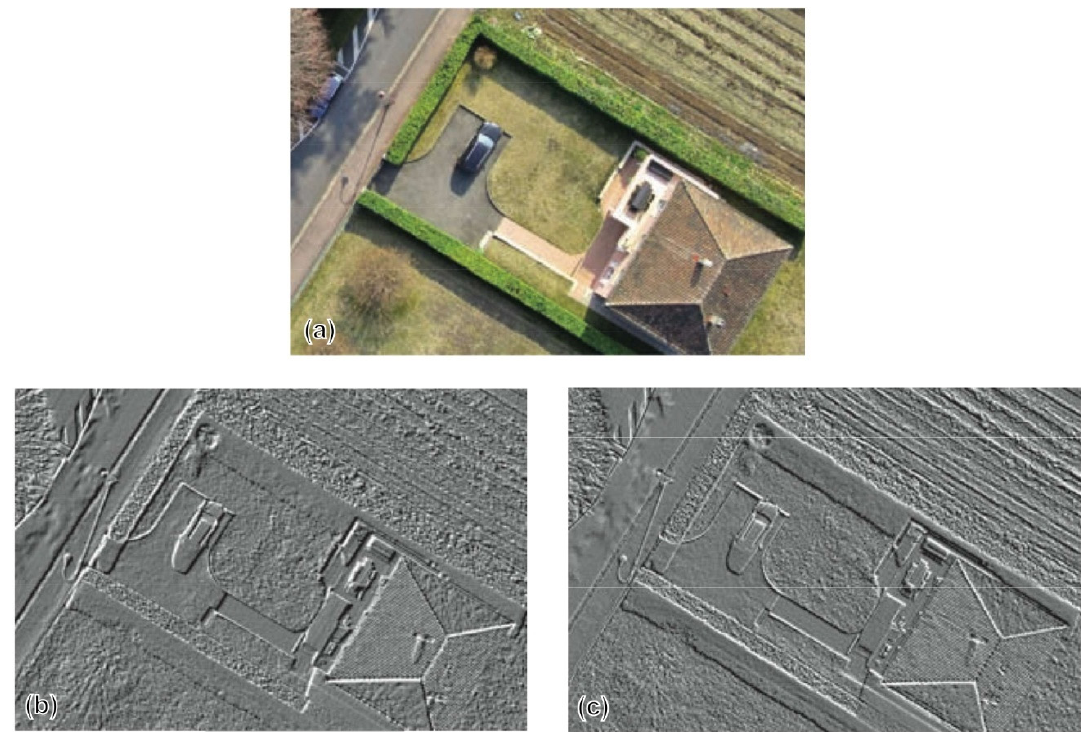
Figure 5. The effect of two different convolution masks on the red band of a high spatial resolution image of a residential area, Germany modified from [64]; ( a ) original image, ( b ) Emboss Northwest filtered image, ( c ) Compass Northeast filtered image.